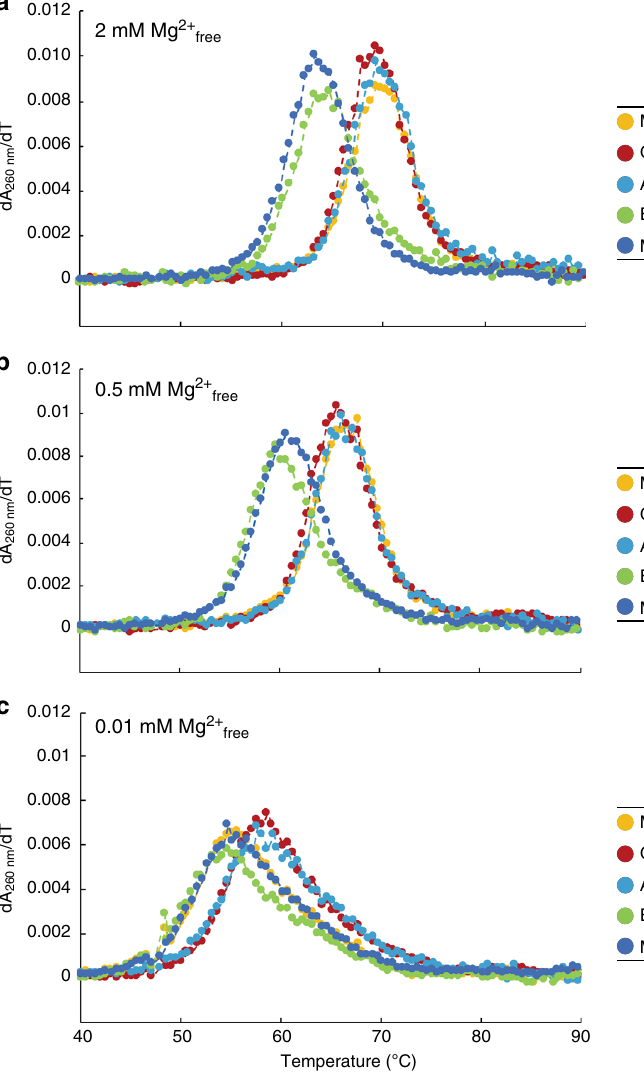
Fig. 1 Amino acid-chelated magnesium promotes RNA thermostability. a Melting curves of drz-spur-3 ribozyme in bacterial conditions; 13.3 mM Mg 2 + total (orange: Mg 2 + high), 96 mM glutamate and 13.3 mM Mg 2 + total (red: GluCM), 106 mM amino acids and 16.0 mM Mg 2 + total (cyan: Aa 4 CM), 11.3 mM EDTA and 13.3 mM Mg 2 + total (green: EDTACM), and 2 mM Mg 2 + total (blue: Mg 2 + low). b , c Melting curves in b eukaryotic conditions and c 0.01 mM Mg 2 + free condition, chosen to test Mg 2 + sensitivity. The same colors as a indicate the same concentrations of the binding donors with different total magnesium concentrations (3.6 mM, 4.6 mM, or 0.5 mM, and 0.074 mM, 0.093 mM, or 0.01 mM,